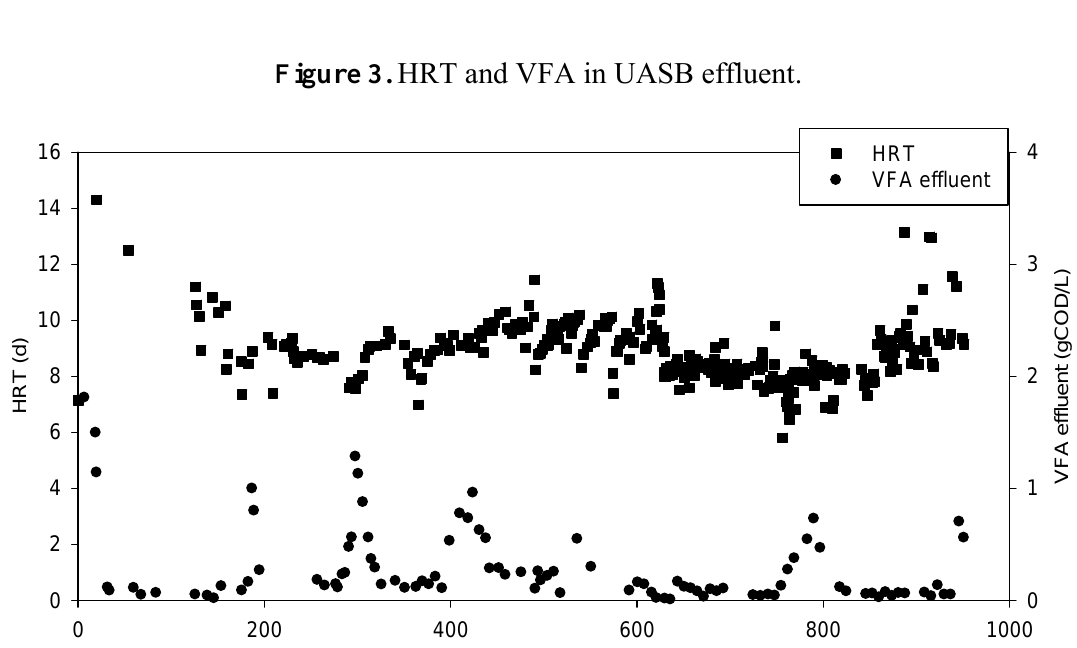
Figure 3. HRT and VFA in UASB